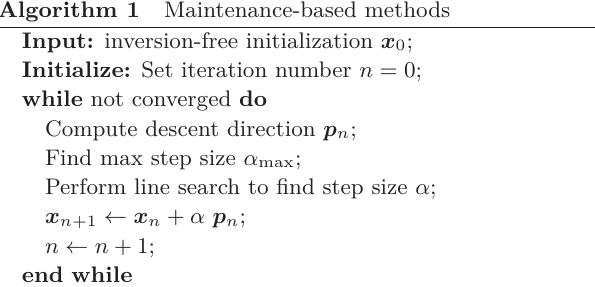
Algorithm 1 Maintenance-based